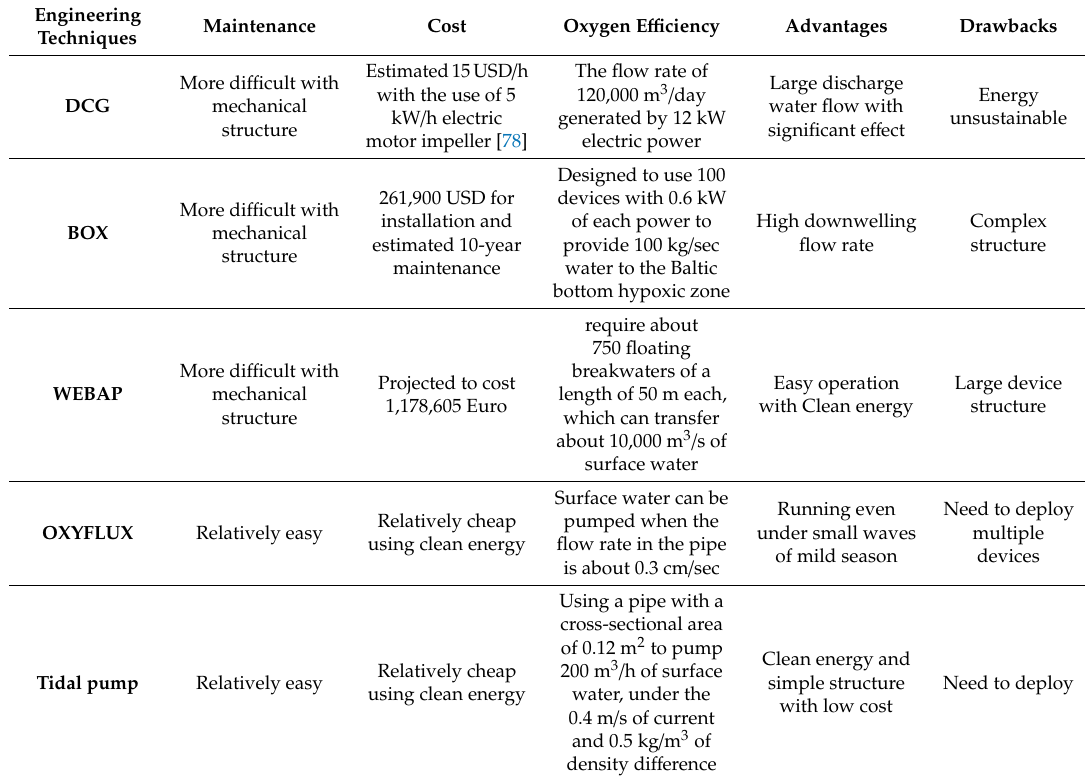
Table 2. Comparison of artificial downwelling